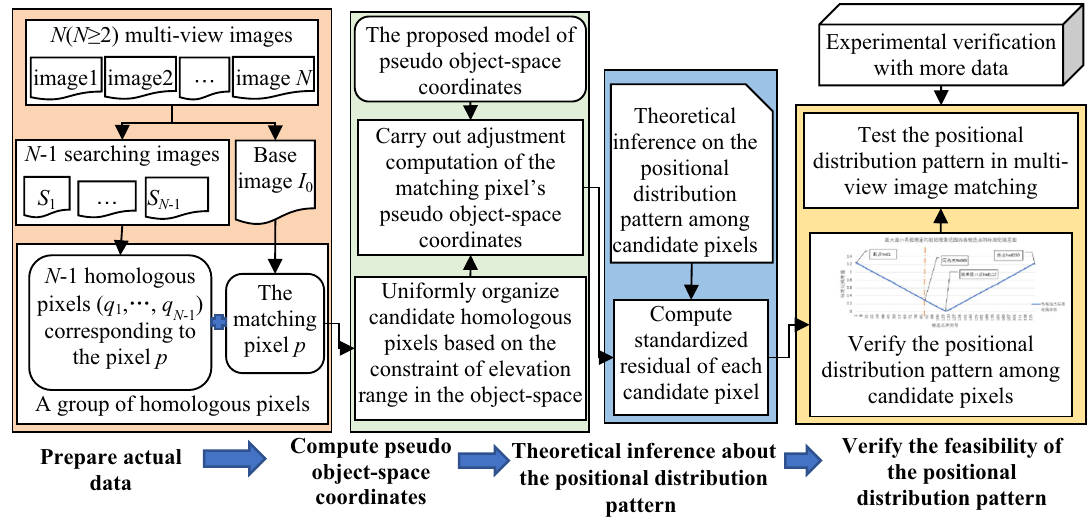
Figure 1. The general flow diagram of the proposed